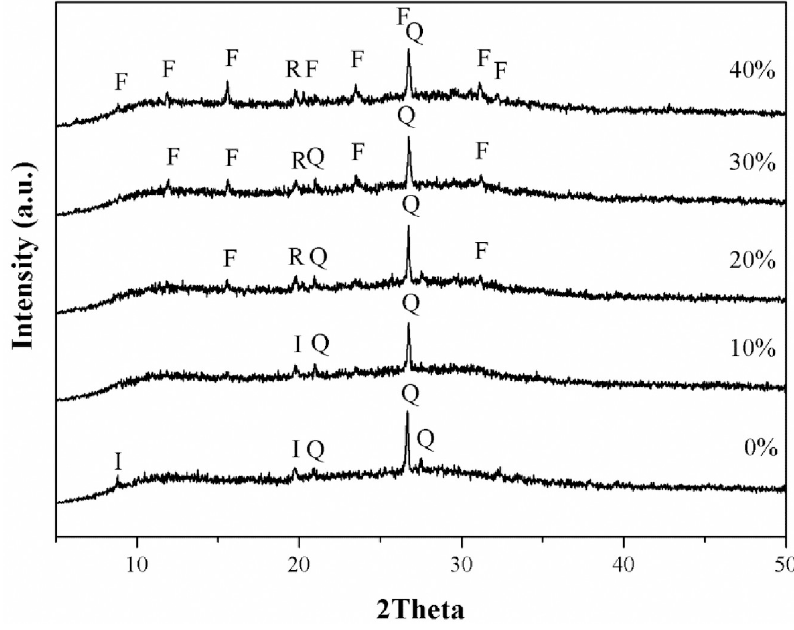
Fig 4. XRD patterns of MK-based geopolymer containing different amounts of TiO 2 /zeolite. I; Illite, Q; Quartz, F: Faujasite, R: Zeolite Rho.